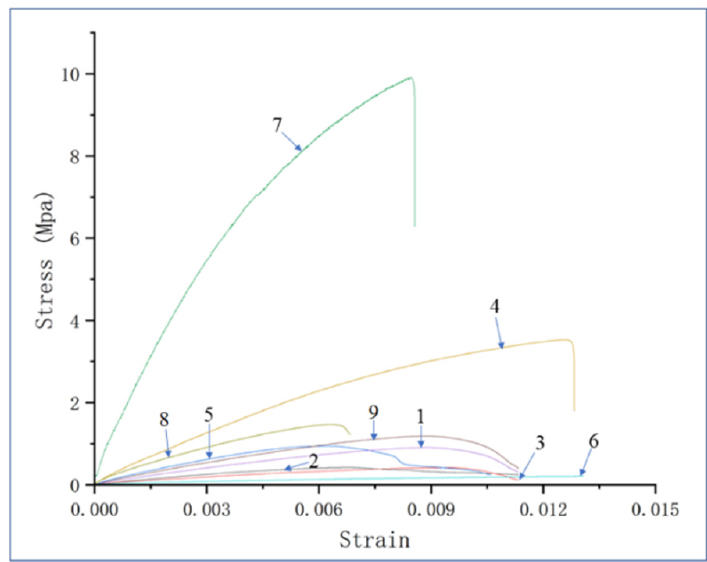
Figure 11. Stress versus strain curve (The numbers in the figure represent different experiment numbers).